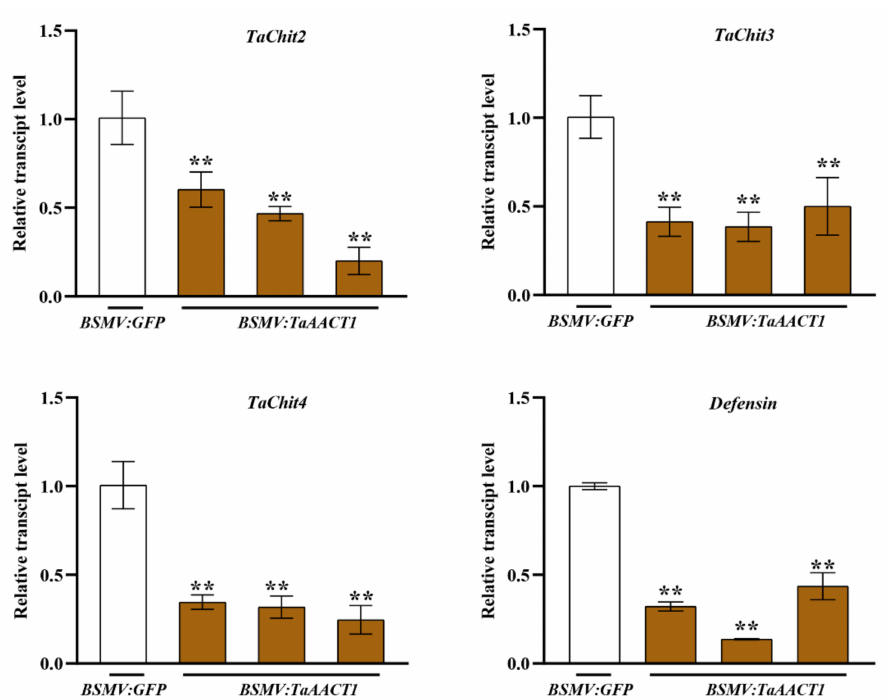
Figure 6. Transcript levels of TaChitinase 2 ( TaChit2 ), TaChitinase 3 ( TaChit3 ), TaChitinase 4 ( TaChit4 ), and TaDefensin in BSMV: GFP -infected and TaAACT1 -silenced wheat CI12633 plants at 4 dpi with F. pseudograminearum WHF220. Relative transcript abundances of the tested genes ( TaChit2 , TaChit3 , TaChit4 , and TaDefensin ) in TaAACT1 -silenced CI12633 plants were quantified relative to thosein BSMV: GFP -infected CI12633 plants (set to 1). Statistically significant differences between TaAACT1 - silenced and BSMV: GFP -infected CI12633 plants were determined based on three replications using Student’s t -test ( t -test: ** p < 0.01). Bars represent standard error of the mean. TaActin was used as internal